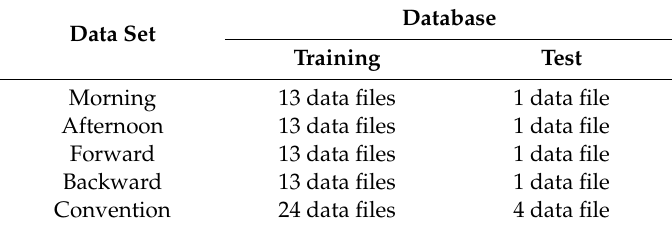
Table 2. Types of the databases and